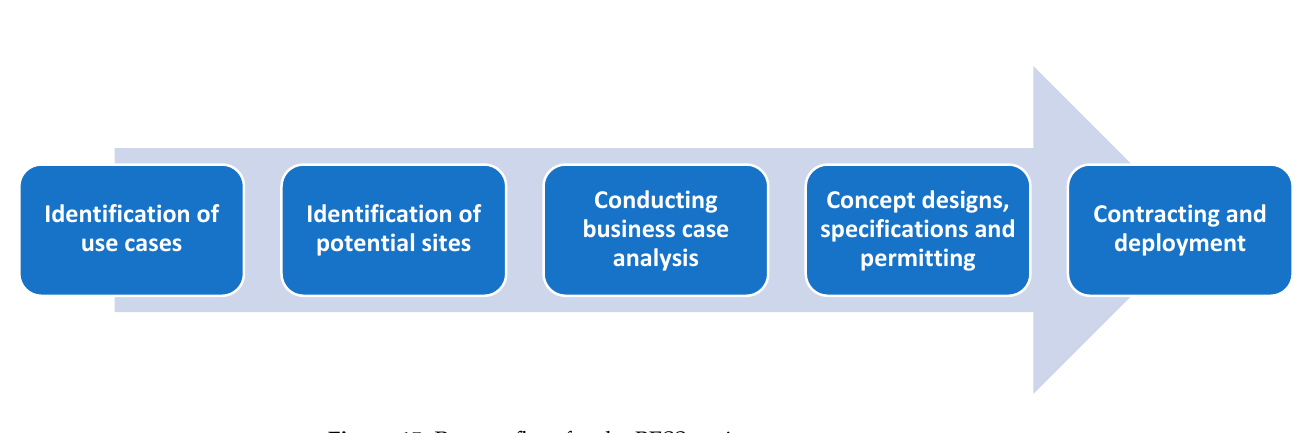
17 of 22 Figure 14. Eskom Paleisheuwel, Western Cape province. 6. Deployment of Utility-Scale Battery Energy Storage The Eskom BESS project involves implementing outcomes at several locations in var- ious operating units (OUs). Sizes of the results range from 1 MW to 60 MW. The standard size of an installation is 4 MW/16 MWh, which equals an estimated total of 90 installations.